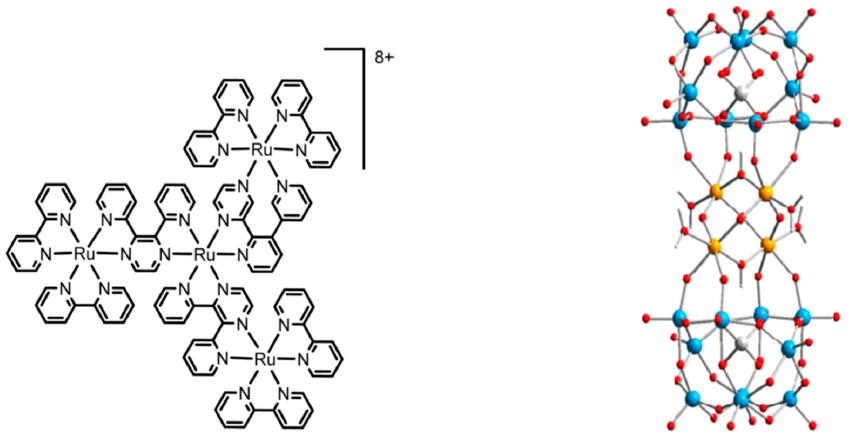
Figure 11. ( left ) Structural formula of [Ru{( μ -2,3-dpp)Ru(bpy) 2 } 3 ] 8+ ; ( right ) Structure of [Ru 4 ( μ - [Ru 4 ( µ -O) 4 ( µ -OH) 2 (H 2 O) 4 ( γ -SiW 10 O 36 ) 2 ] 10 −